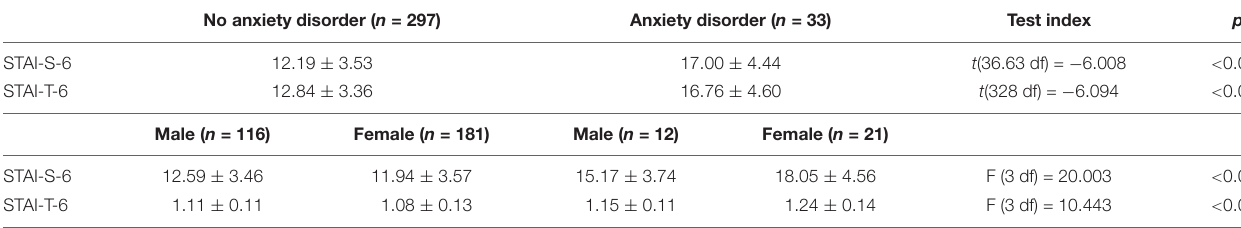
TABLE 12 | Area under the curve (AUC) analyses ( n =